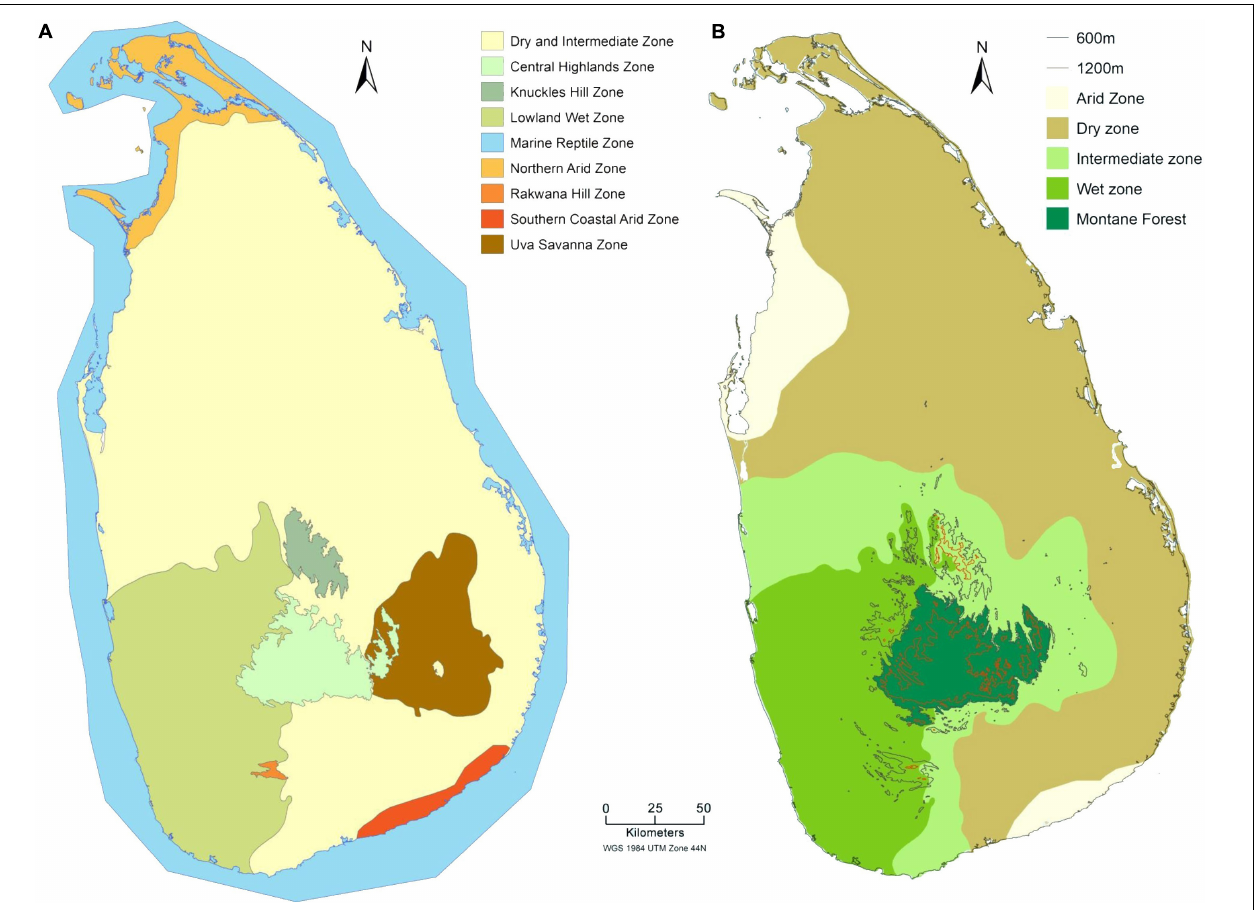
FIGURE 2 | Sri Lanka climatic zone maps. (A) Nine distinctive reptile zones (Ministry of Mahaweli Development and Environment, 2019) and (B) Five distinctive bioclimatic zones.